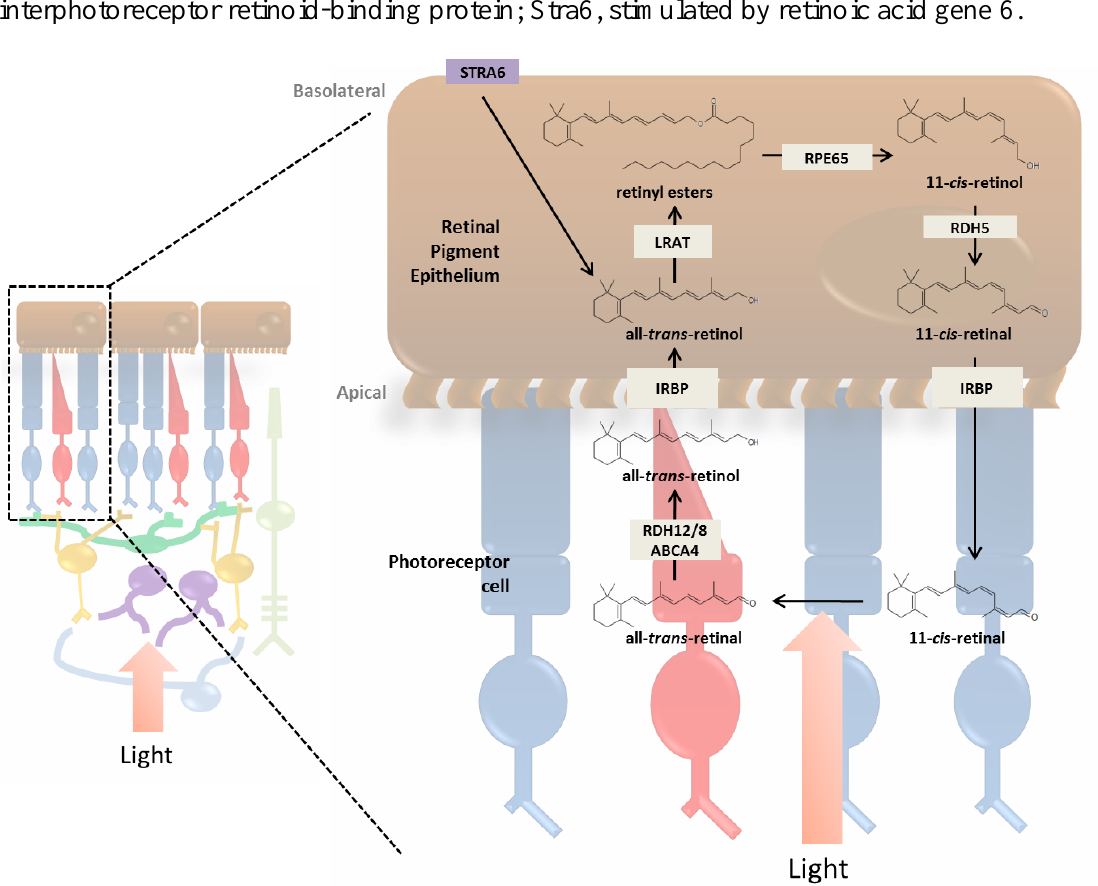
Figure 2. Visual cycle. Absorption of light by visual pigments (rhodopsin or cone opsin) causes isomerization of 11- cis -retinal to all- trans -retinal, resulting in phototransduction. Decay of activated rhodopsin yields opsin and all- trans -retinal, which is released and pumped out into the cytosol by a photoreceptor specific ATP-binding transporter (ABCA4) and reduced to all- trans -retinol by all- trans -retinal dehydrogenases (RDH8 and RDH12). All- trans -retinol diffuses into the RPE where it is esterified by lecithin:retinol acyltransferase (LRAT) to all- trans -retinyl esters, which are stored in retinosomes. All- trans -retinyl esters are isomerized to 11- cis -retinol in a reaction involving a 65 kDa RPE-specific protein (RPE65). To complete the visual cycle, 11- cis -retinol is then oxidized by 11- cis –retinal specific RDH (RDH5) to 11- cis -retinal, which then diffuses back into the photoreceptor where it combines with opsin to regenerate visual pigments.